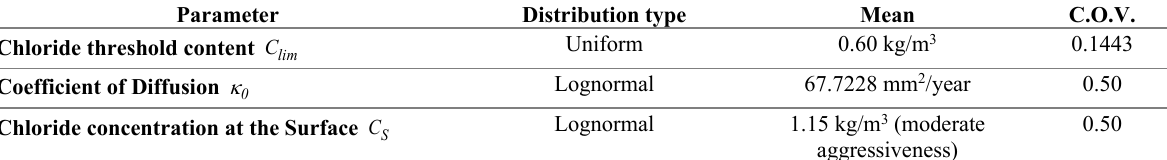
Table 1 – Statistical data for application